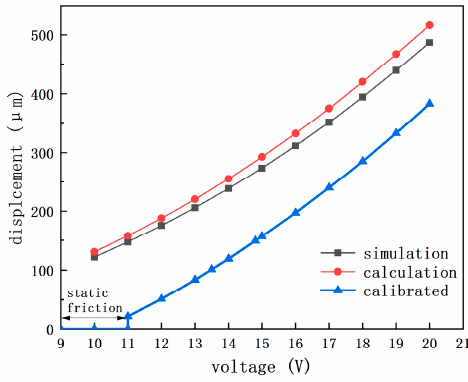
Figure 13. The profiles of displacement output along with input voltage.